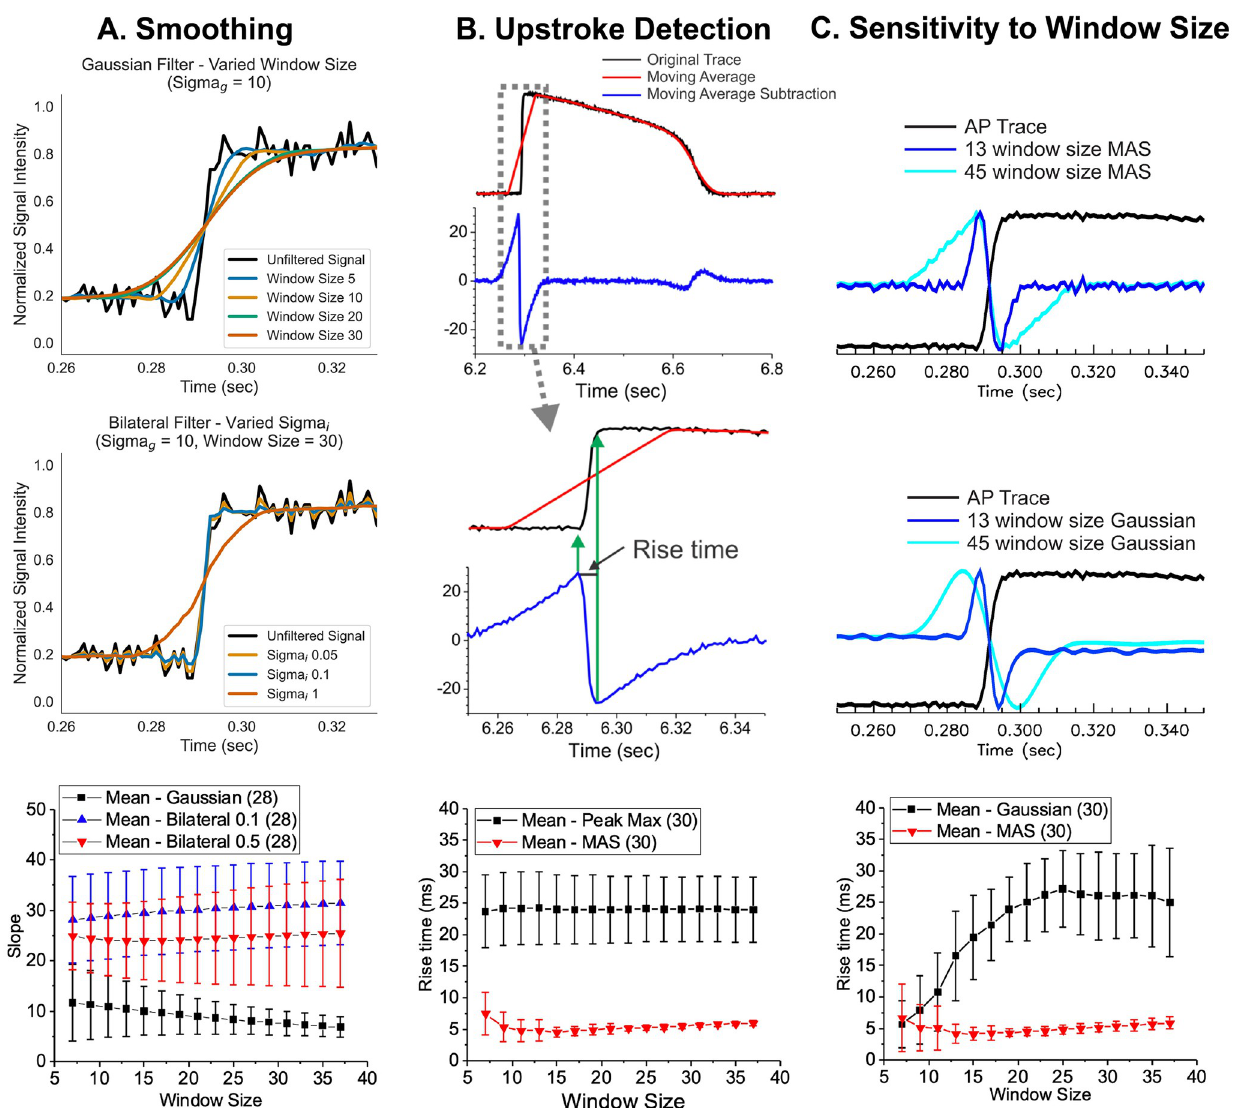
Fig 6. AP upstroke analysis. (A) Non-linear bilateral filter to preserve the sharpness of AP upstroke. Sample traces of AP before (black) and after applying Gaussian (top panel traces, blue to red) and bilateral (middle panel traces, blue to red) filters. AP upstroke is preserved after bilateral filtering even with a significantly larger window size (middle panel) compared to typical Gaussian filtering (top panel). The slope of AP upstroke was steeper with bilateral filter vs. gaussian filter (triangle for bilateral vs. black square plots for gaussian filter in the bottom panel), showing the advantage of edge-preserving bilateral filter to reduce noise in AP traces. (B) Upstroke detection using a moving average subtraction algorithm to detect the takeoff and peak time of AP upstroke. The moving average was calculated (red, window size = 45 points) and the original trace (black) was subtracted (blue), which detects a rapid change in AP upstroke. The middle traces show that the maximum of moving average subtraction (MAS) occurs at the initial rise of AP upstroke and the minimum of MAS occurs when the rapid rise of the AP upstroke is finished. The bottom panel compares the rise time of AP upstroke measured by time-to-max vs. MAS method. After sufficient filtering with 15-point bilateral filter, the standard deviation of the rise time measurements using MAS is significantly lower, increasing sensitivity to detect potential changes in AP upstroke by Na + channel blockers. (C) AP upstroke analysis by MAS compared to Gaussian 2 nd derivatives. The rise time measurement using MAS is less sensitive to the choice of window size (top), while the rise time measurement using Gaussian 2 nd derivatives (middle) is highly sensitive to the choice of window size